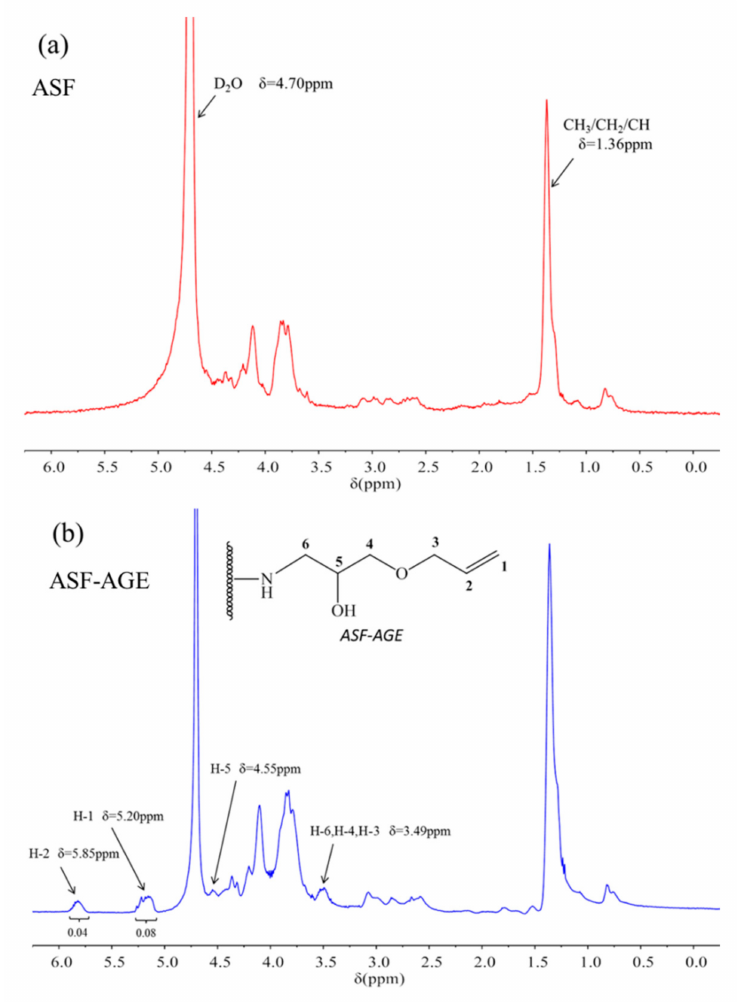
Figure 3. 1 H NMR spectra of ( a ) ASF and ( b )